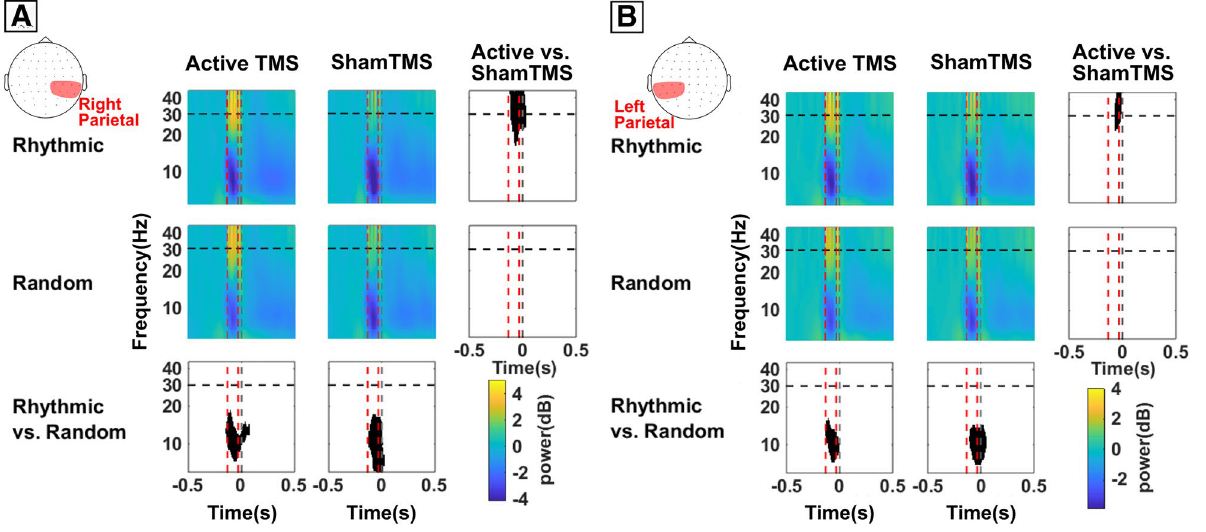
Figure 4. Temporal dynamics and frequency-specificity of high beta local entrainment (power) on parietal regions across stimulation patterns delivered to the right FEF. Time frequency plots representing oscillation power over right parietal ( A ) or left parietal ( B ) electrodes. Time frequency panels are arranged following a 2 × 2 crossed factorial design, in which we compared sham vs. active TMS condition (rows) and random vs. rhythmic TMS patterns (columns). Time is centered on the onset of the visual target (vertical dotted grey line, t = 0). Vertical dotted red lines indicate the time window between the 1st (− 133 ms) and the 4th and last (− 33 ms) TMS pulses of the delivered stimulation pattern. The horizontal dotted black line indicates the delivered frequency of stimulation (30 Hz) for rhythmic patterns. Bottom and right panels present the outcomes of the statistical permutation tests, with black pixels indicating clusters that reached statistical significance between TMS conditions (p < 0.05), either active/sham rhythmic vs active/sham random (bottom row) or active